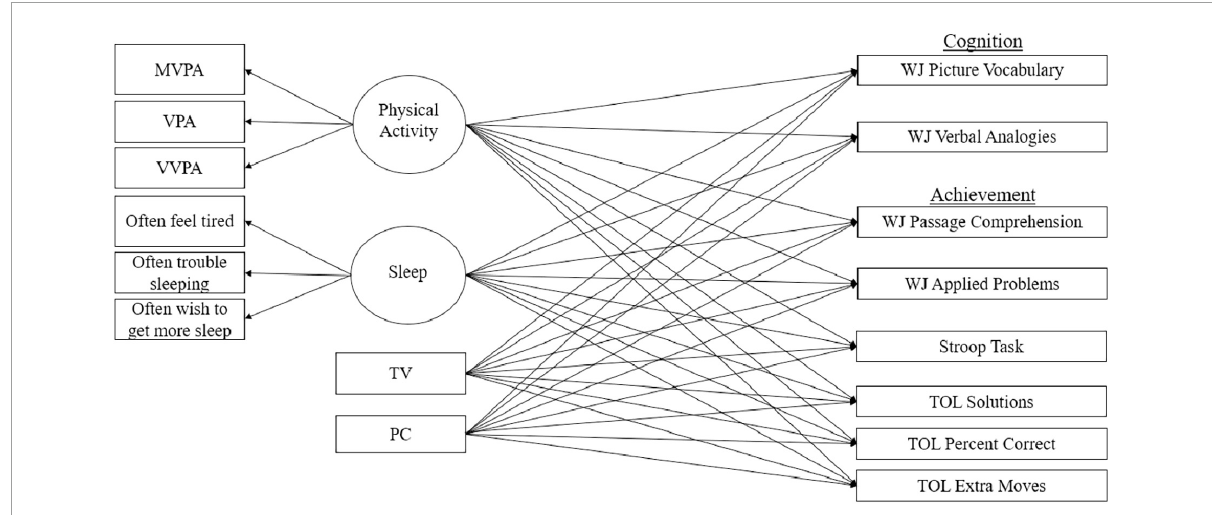
FIGURE1 Path model for primary analysis. MVPA, moderate to vigorous physical activity; VPA, vigorous physical activity; VVPA, very vigorous physical activity; TV, television viewing; PC, recreational personal computer time; WJ, Woodcock Johnson; ToL, Tower of